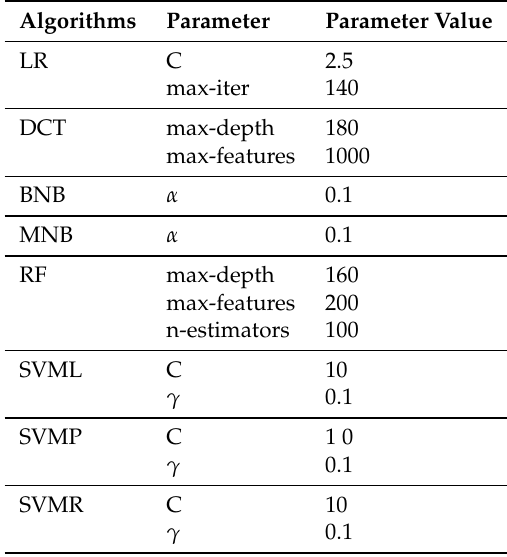
Table 5. Parameter